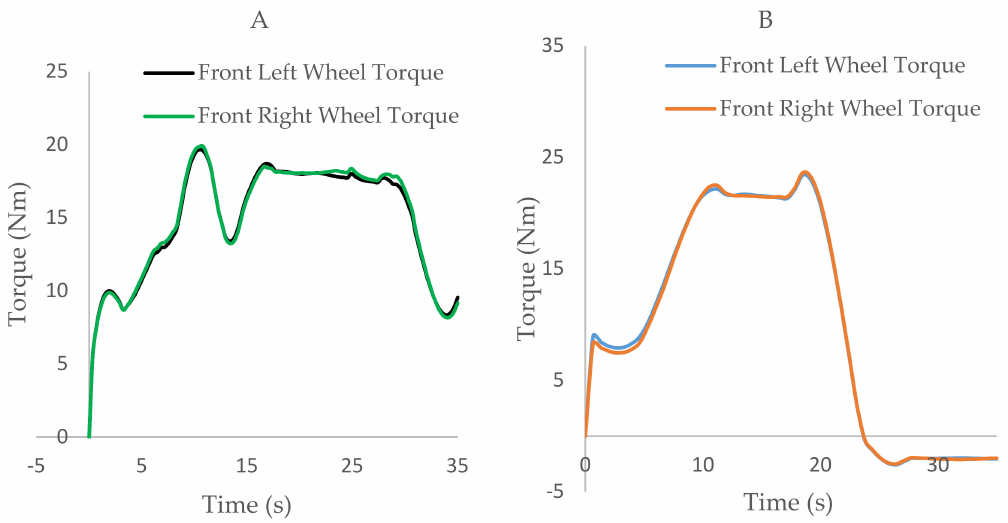
Figure 15. Torque performances ( A ) with control and ( B ) without